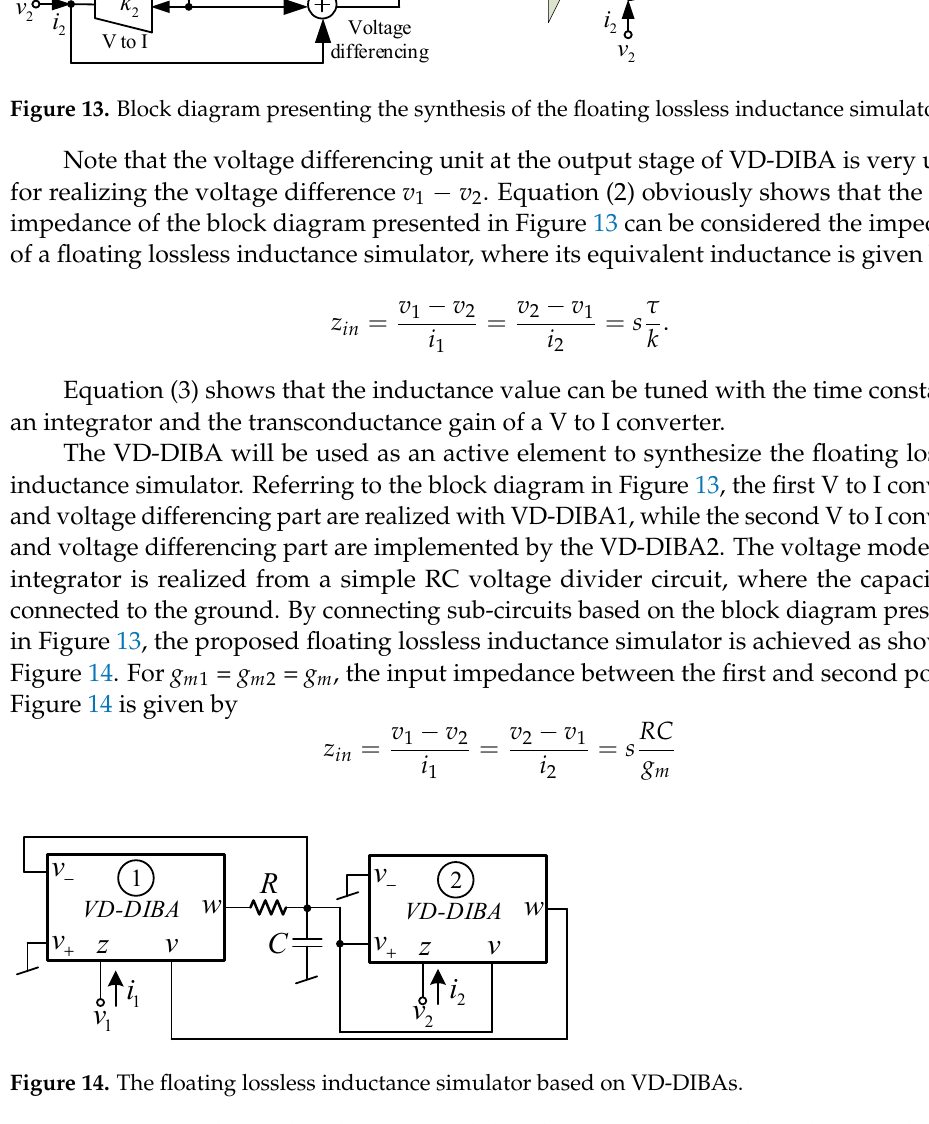
= Figure 15. Block diagram showing the synthesis of the floating series inductance-resistance simu- lator. As can be concluded from (6), the input impedance of the block diagram in Figure 15 can be considered the impedance of the floating series connection of an inductor and a resistor, where its equivalent inductance value is the same as that given by (2) and the equivalent resistance value is given by